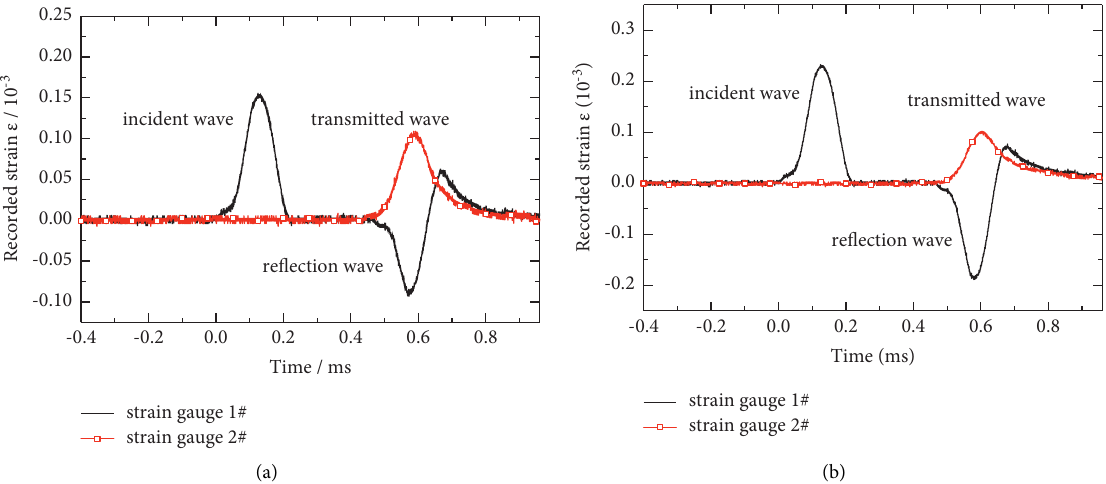
Figure 5: The recordings of strain gauges for specimen with and without joint. (a) The waveform of intact specimen S0. (b) The typical waveform of jointed specimen S7.